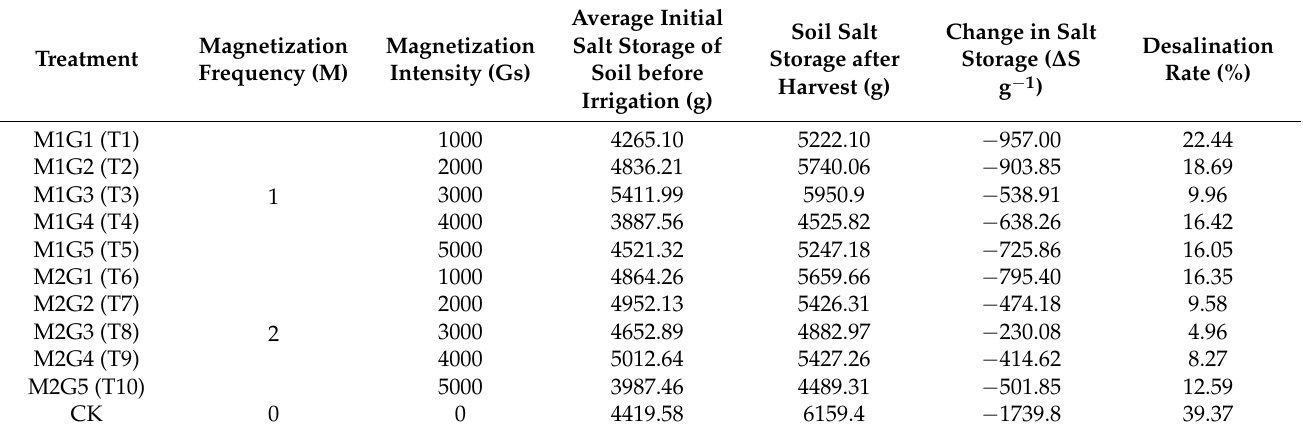
Table 5. Changes to salt storage in the 0–160 cm soil layer before and after the growth period of jujube under magnetized brackish water